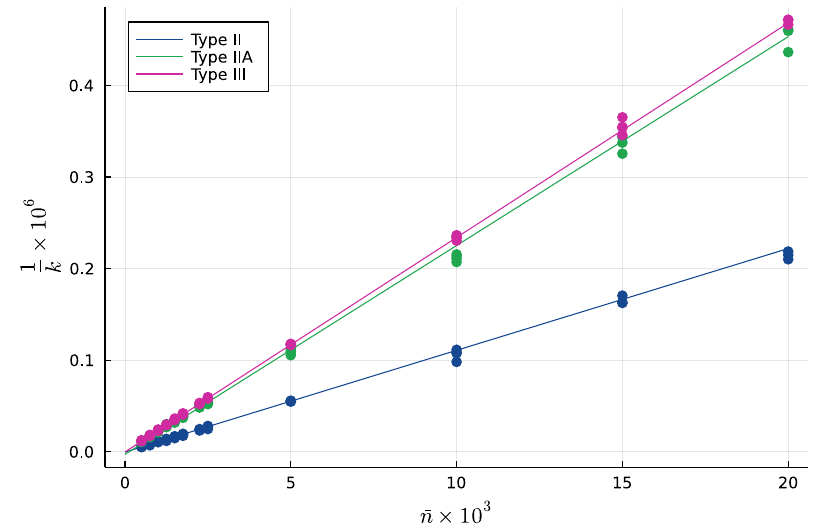
Figure 8. The inverse kinetic coefficients 1 /k as a function of the volume per slice ¯ n . The data points are color grouped by ensemble types II (blue), IIA (green), and III (purple). The spatial genera used in the simulations are g ∈ { 0 , 1 , 5 , 10 , 15 } . The straight lines are linear fits to the genus 1 data obtained for the three distinct ensemble types. (Error bars are on the order of the dot